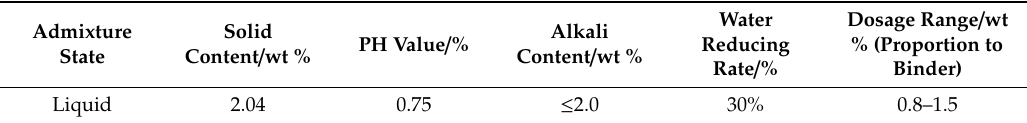
Table 4. Basic performance parameters of the polycarboxylic high-performance superplasticizer (JMPCA).